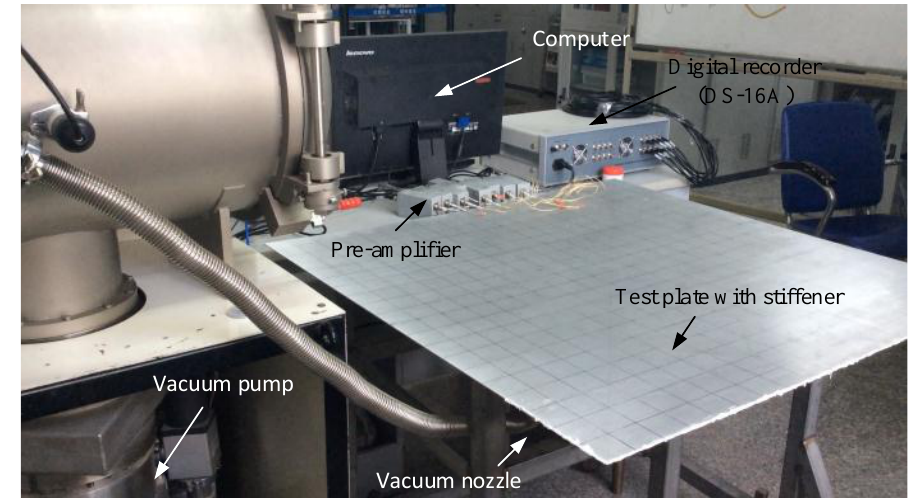
Figure 12. Experimental